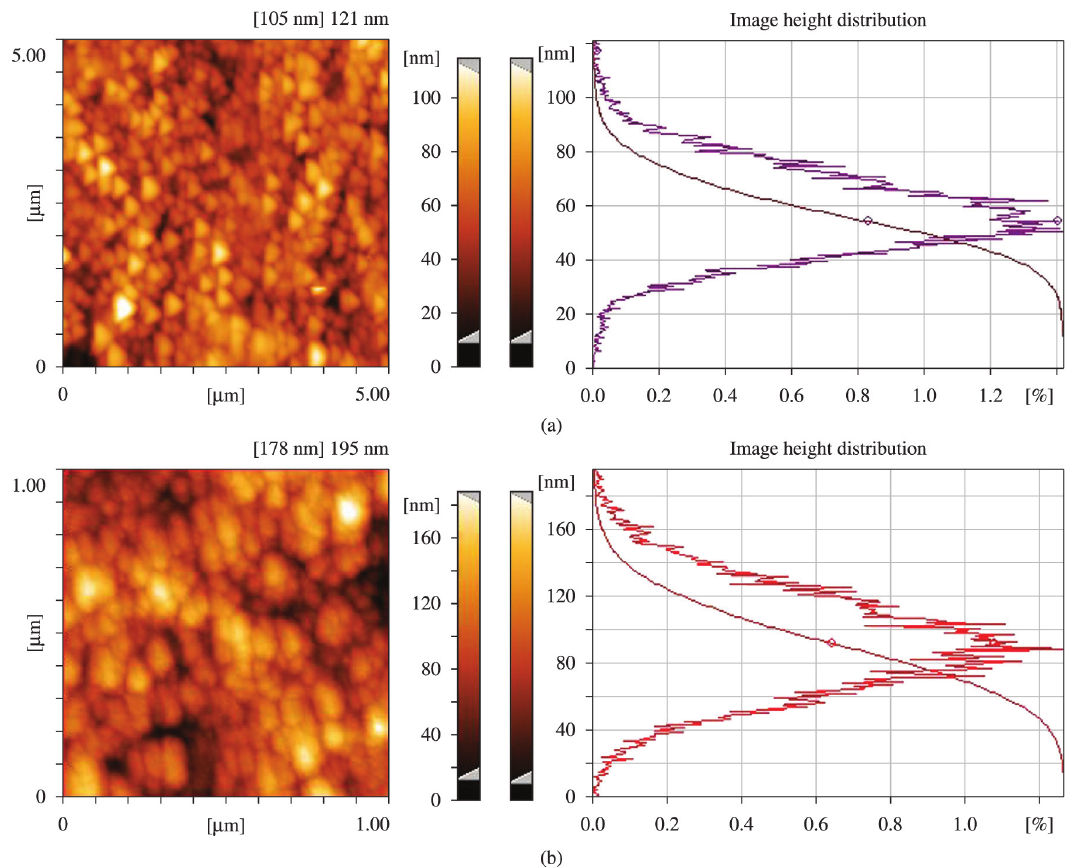
Figure 5. Morphology of TiCN thin films via the CH4/ (CH4+N2) gas flow ratio, evaluated by AFM. a)50% b)66%.